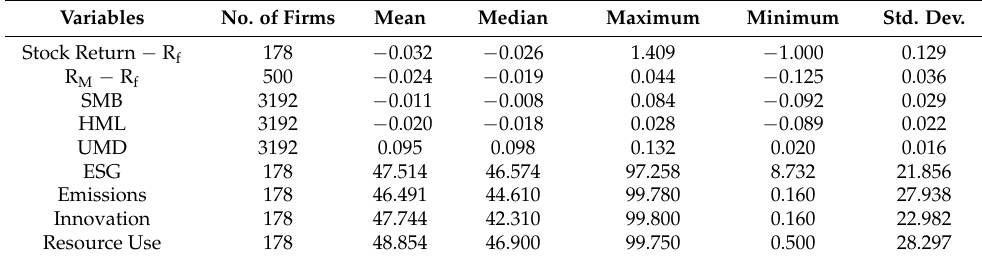
Table 1. Descriptive statistics.